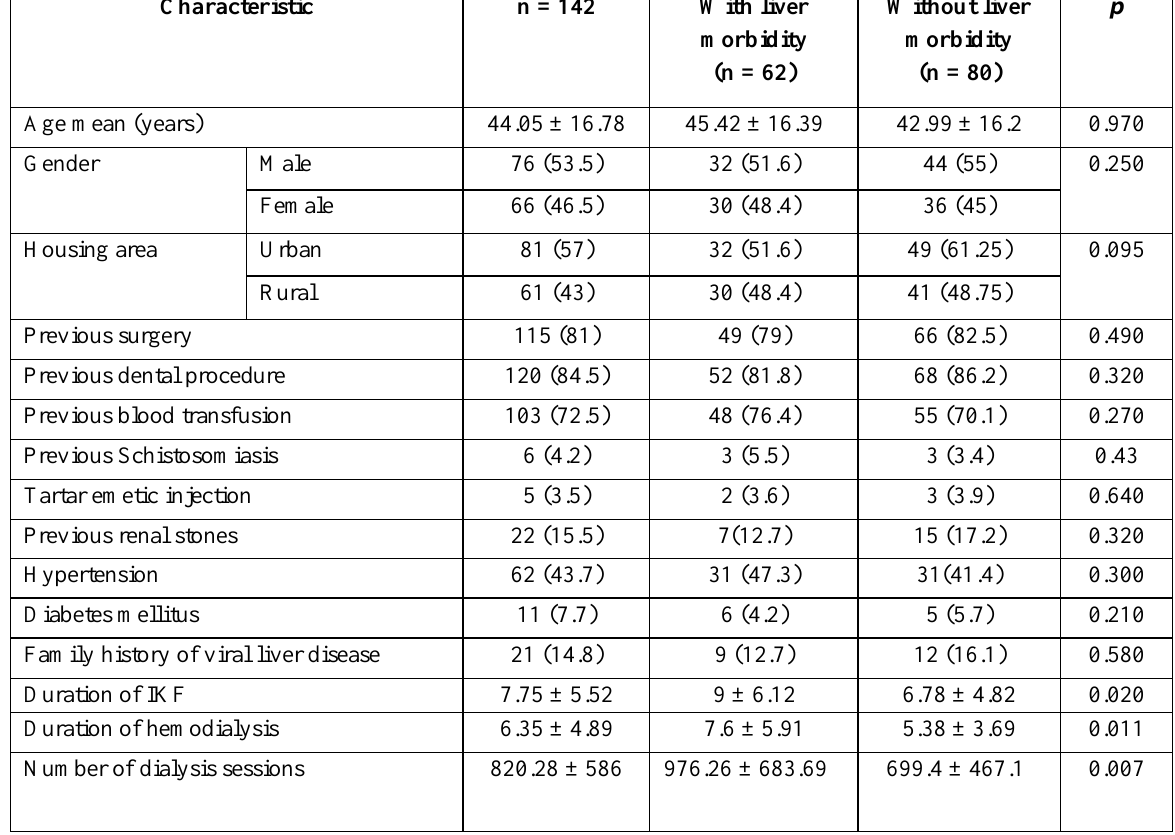
Table 1. Socio-demographics and risk factors stratified for liver morbidity among the study hemodialysis patients.